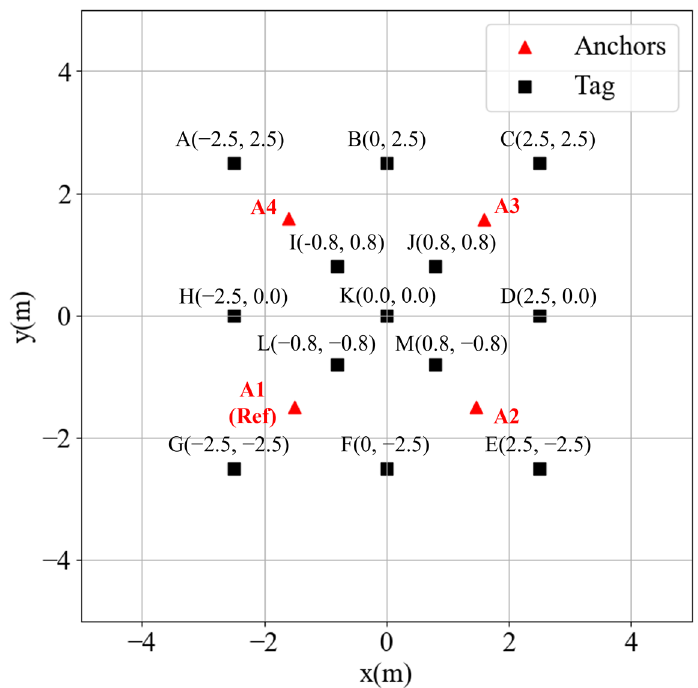
Figure 9. Testing points.